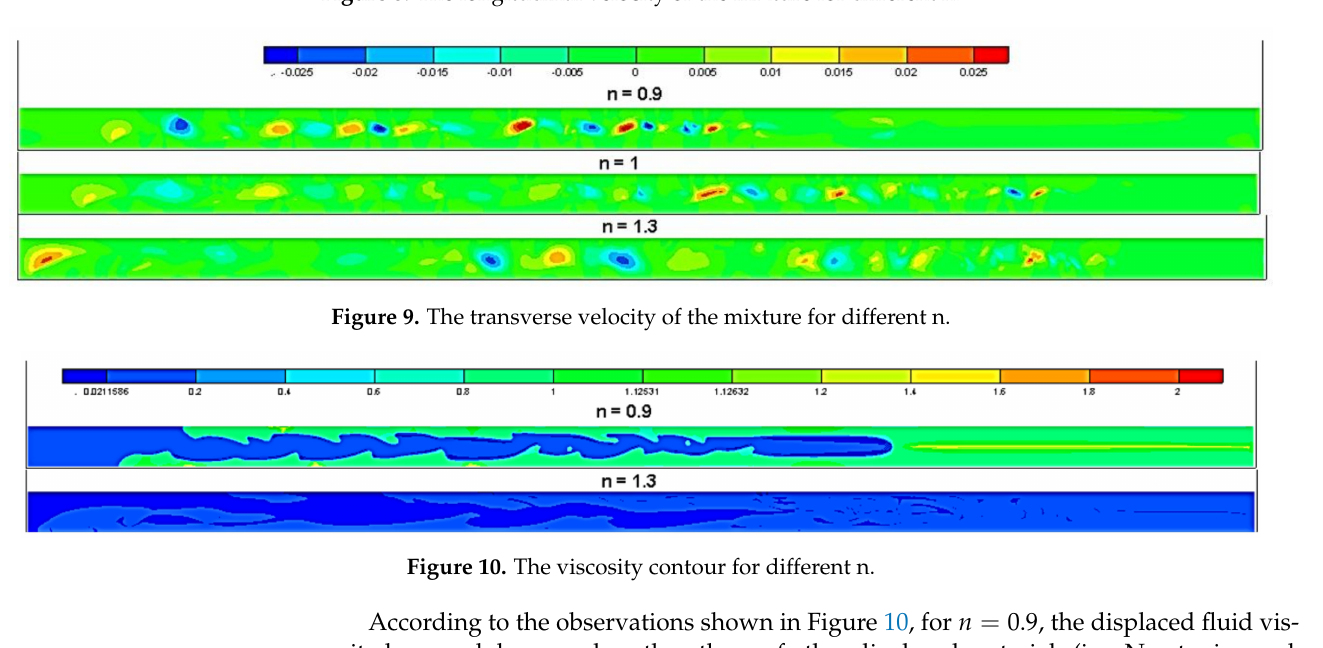
Figure 8. The longitudinal velocity of the mixture for different n.